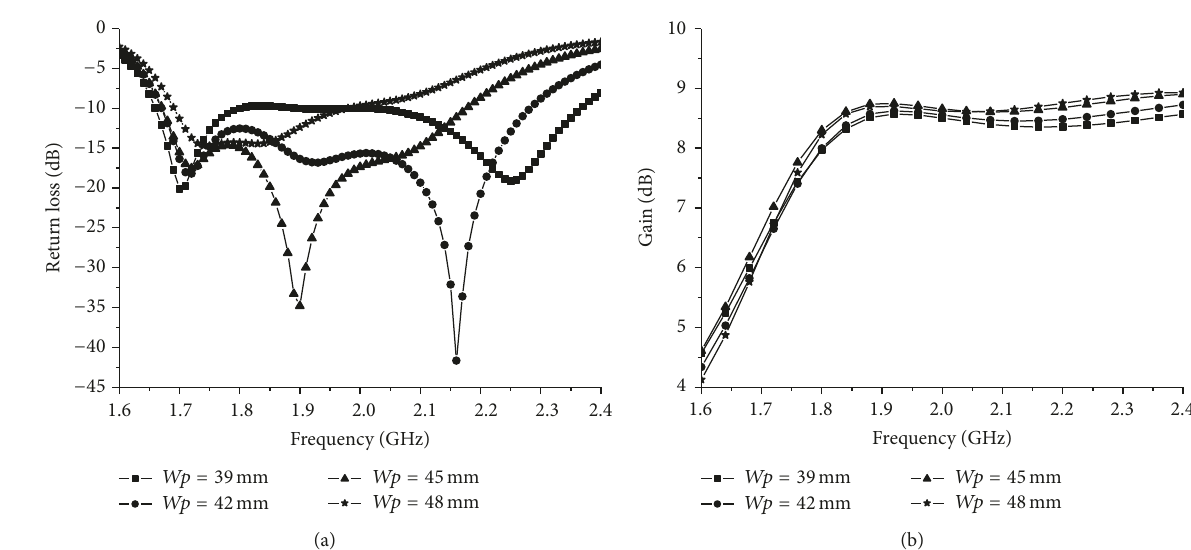
Figure 9: Effect of the width of the upper patch 𝑊𝑝 . (a) Return loss. (b) Antenna